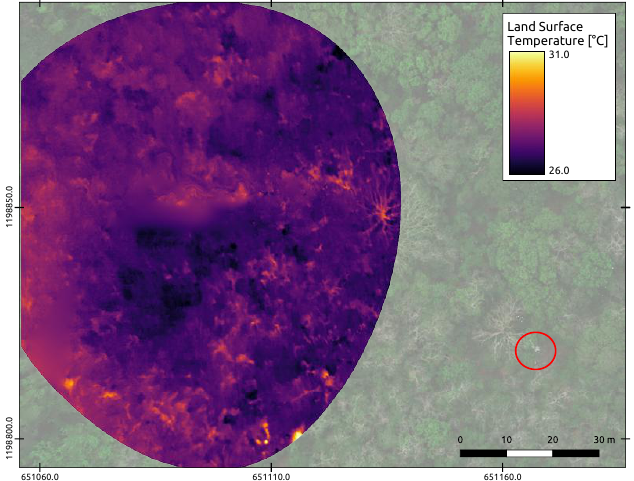
Figure 5. Spatial distribution of the rededge based vegetation index (RENDVI) cropped for the footprint of the EC system. Red circle indicates the position of the EC system.